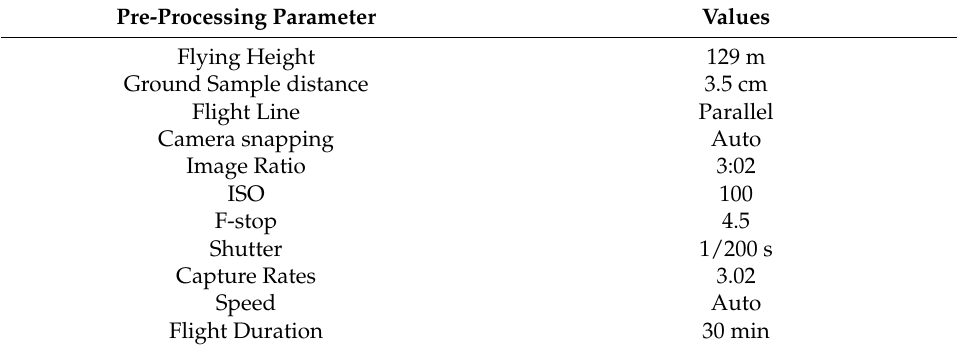
Figure 2. ( a ). Phantom 4 Pro UAV. ( b ) Researcher controlling the UAV. ( c ) Flight path. Table 1. Flying path for control movement.